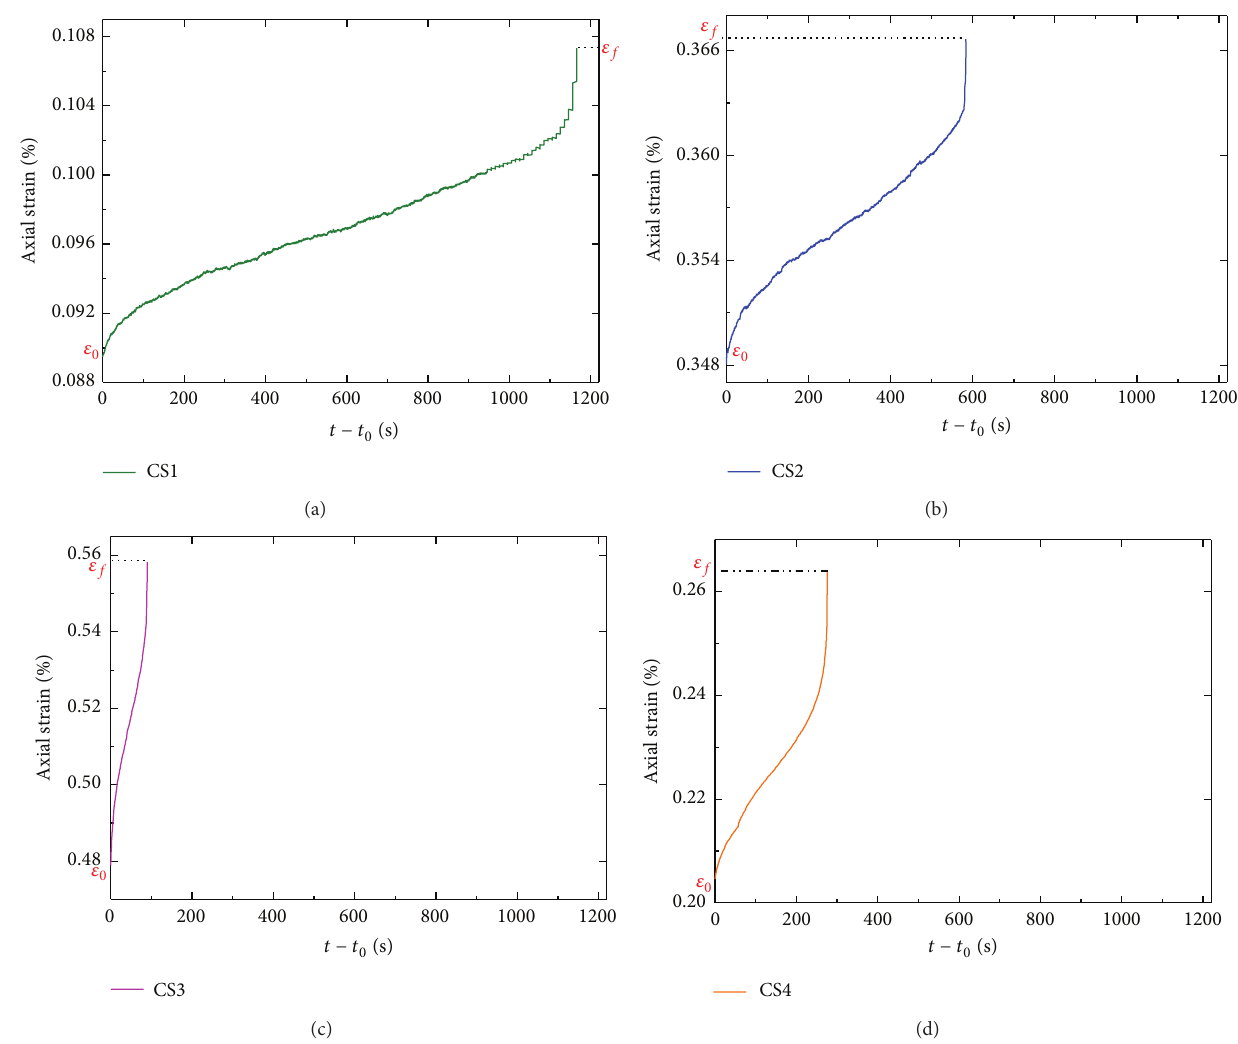
Figure 6: Axial strain versus time curves of four concrete specimens at the creep phases from 𝑡 0 to failure under a constant applied stress. (a) Sample CS1; (b) sample CS2; (c) sample CS3; (d) sample CS4. The curves show the three typical stages of brittle creep: (1) primary (transient) stage characterized by an increasing strain with deceleration, (2) secondary stage, and (3) tertiary stage characterized by accelerating creep.